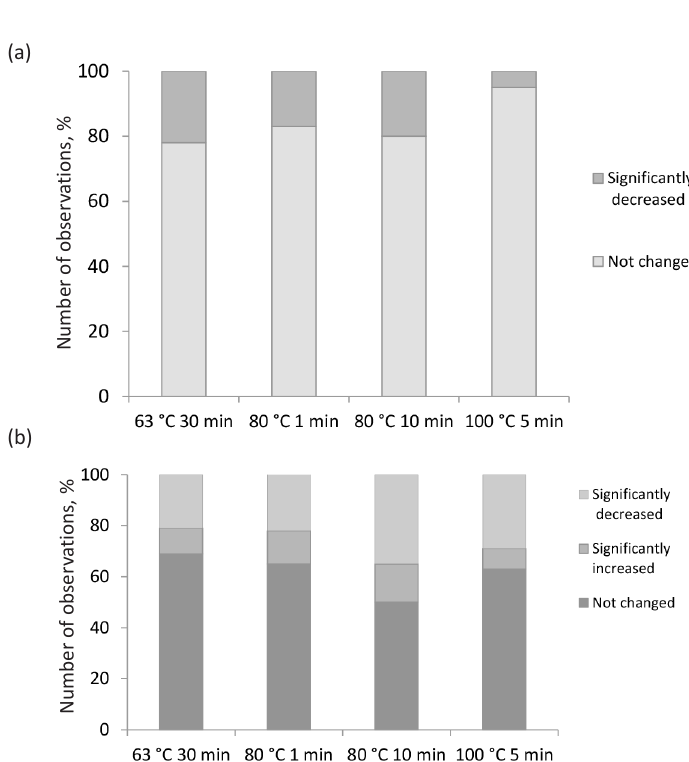
Fig. 1. Changes of antibacterial (a) and antifungal (b) activity during thermal treatment comparing with control points. Number of observations: twelve CFS of LAB cultures vs . five reference bacterial strains (12×5) (a) and twelve LAB vs . four micromycetes foodborne strains (12×4)